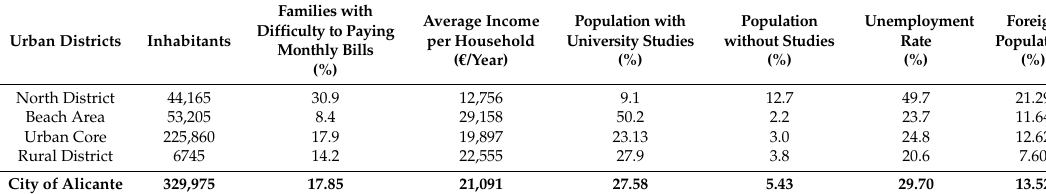
Table 2. Main socio-economic data of the differentiated urban areas of the city of Alicante (2016).